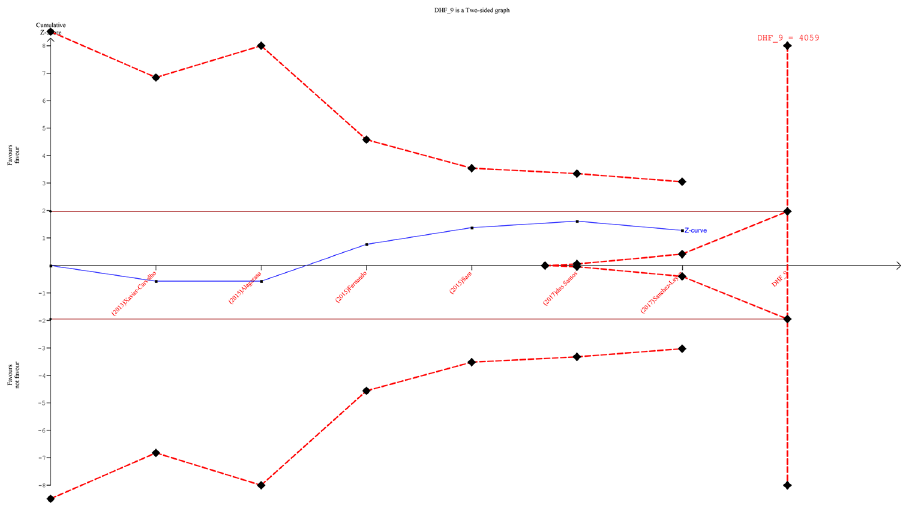
Fig 5. Trial sequential monitoring plot of TNF- α -308 G > A in severe dengue infection.